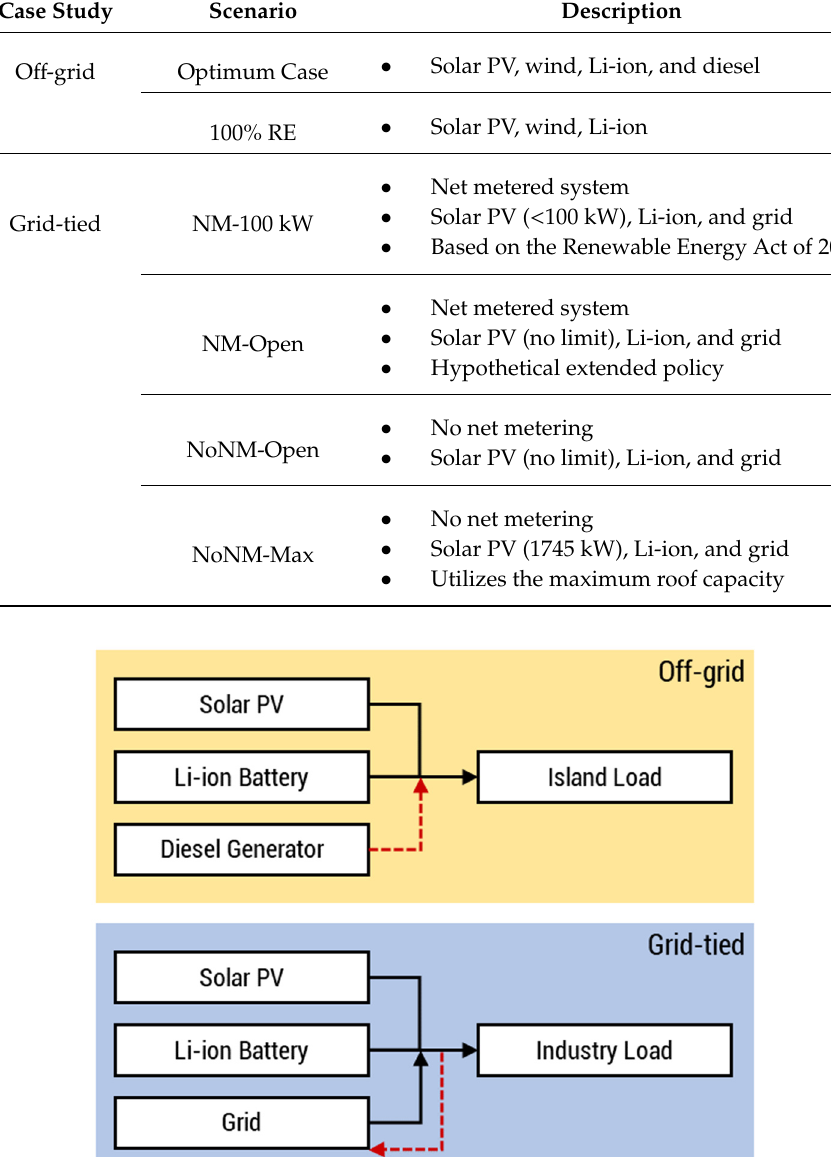
Table 1. Energy system LCOE calculation scenarios.